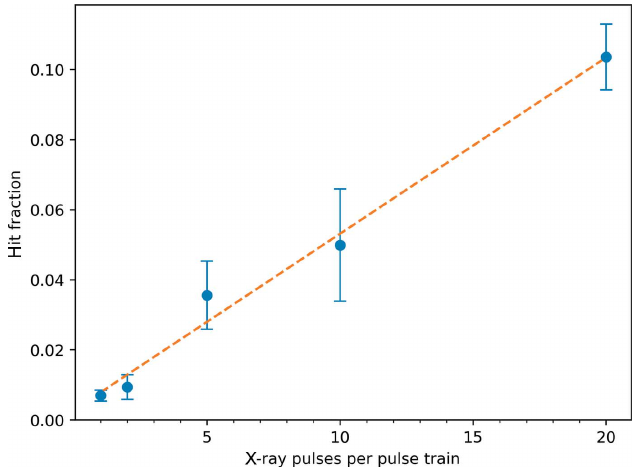
Figure 7 Hit fraction for different numbers of X-ray pulses in each pulse train. The error bars are derived from the standard deviation of hit fractions from many data collection runs under similar conditions. The dashed line is a linear